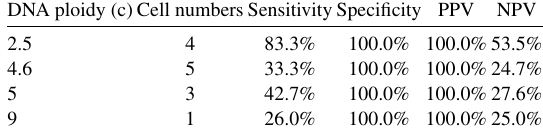
Diagnostic accuracy using DNA ploidy diagnostic threshold values of different kinds of cytologic specimens DNA ploidy (c) Cell numbers Sensitivity Specificity PPV